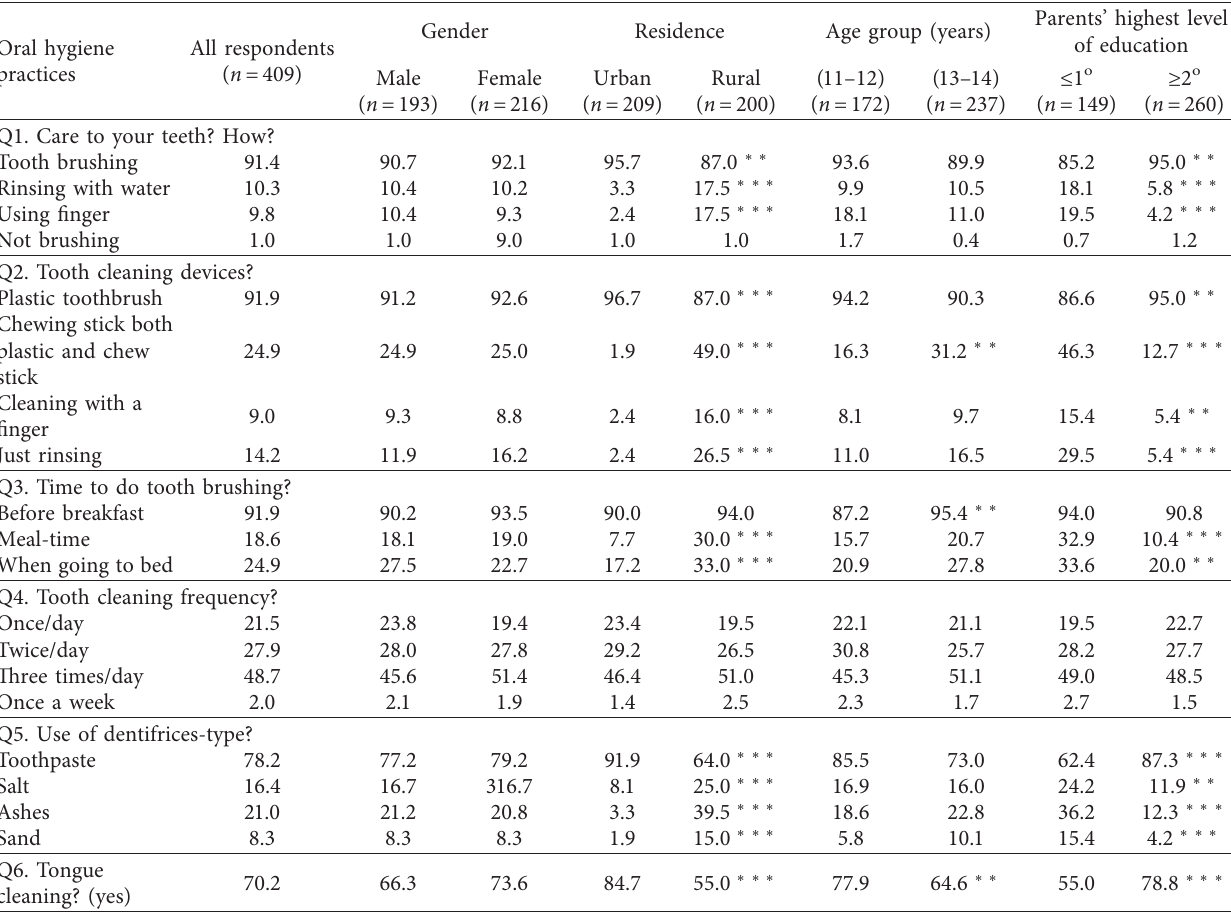
Table 2: Oral hygiene practices among the primary schoolchildren by sociodemographic factors (in